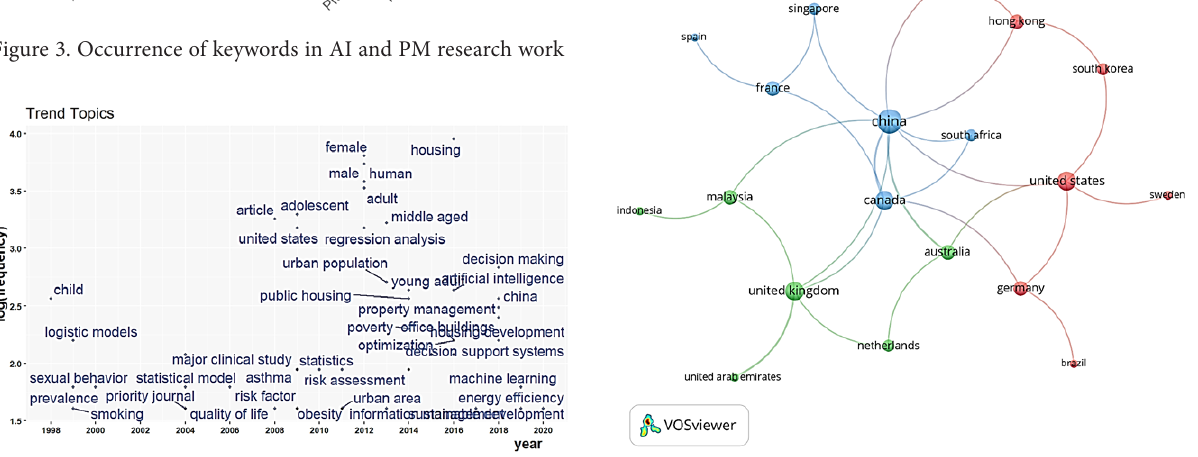
Figure 6. Collaboration network by countries in AI and PM